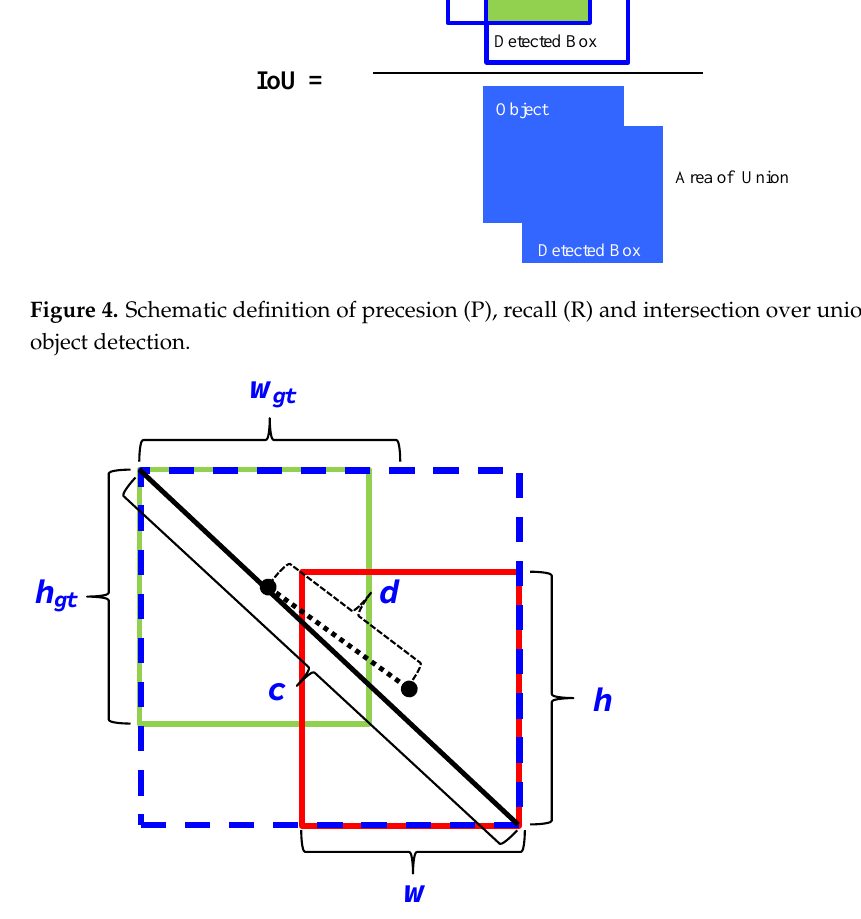
Figure 5. Schematic of offset regression for target bounding box prediction process during CIoU loss in bounding box regression for proposed object detection